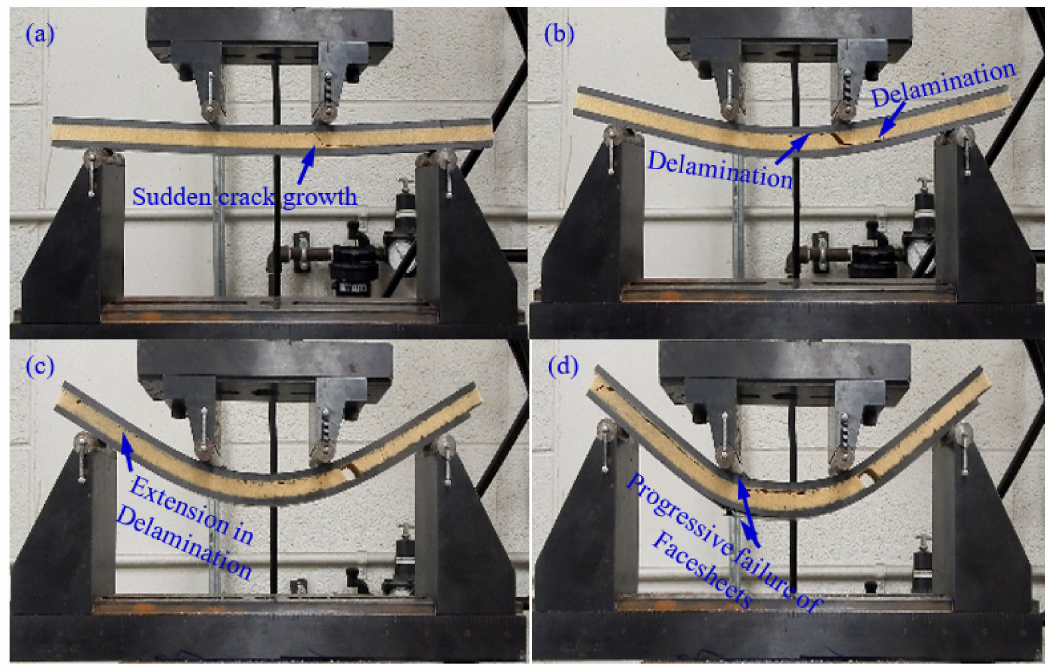
Figure 5. Damage morphologies of a CFRP / PU foam sandwich beam with a thin core under four-point flexural loading: ( a ) Crack occurrence; ( b ) Delamination; ( c ) Delamination Propagation; ( d ) Facesheets Progressive